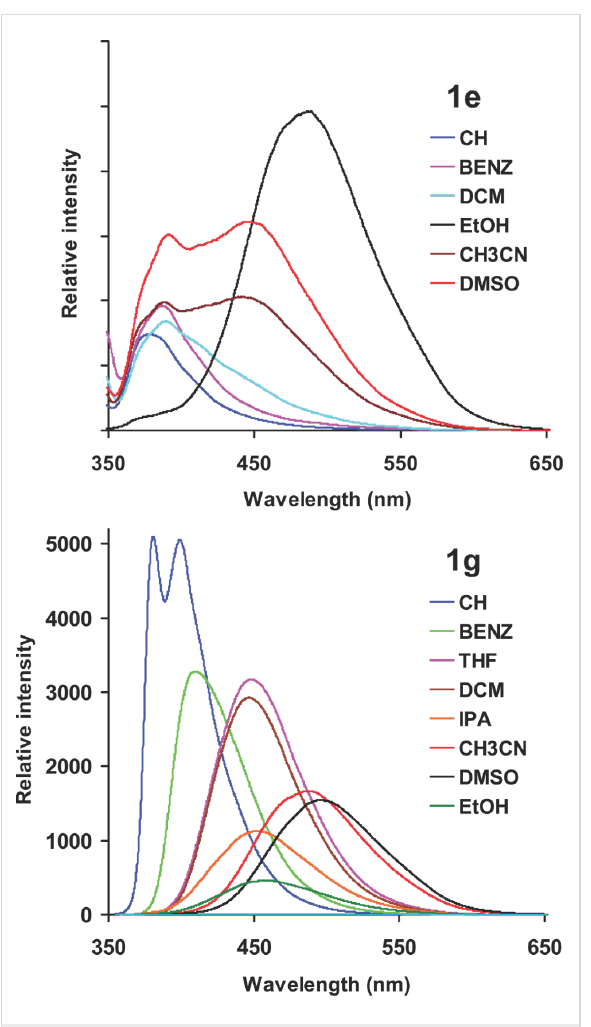
Figure 3: Fluorescence emission spectra of 1e and 1g in various solvents (10 − 5 M). CH – cyclohexane ( λ ex = 334 nm ( 1e ) and 345 nm ( 1g )), BENZ – benzene ( λ ex = 338 nm ( 1e ) and 335 nm ( 1g )), DCM – dichloromethane ( λ ex = 336 nm ( 1e ) and 357 nm ( 1g )), IPA – isopropyl alcohol CH 3 CN ( λ ex = 348 nm ( 1g )), DMSO ( λ ex = 338 nm ( 1e ) and 367 nm ( 1g ). EtOH ( λ ex = 335 nm ( 1e and 1g )), THF ( λ ex = 356 nm ( 1g )).